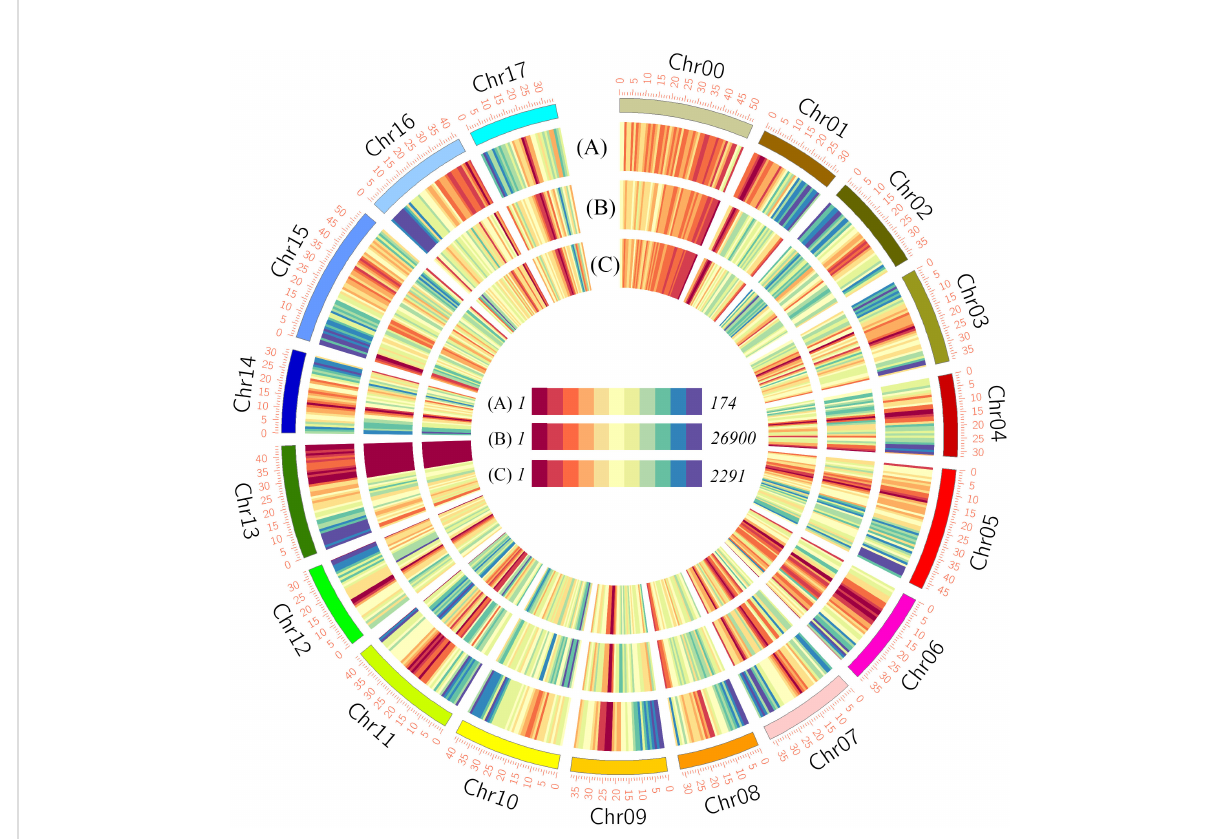
FIGURE 2 Circular overview of the variations between ‘ HanFu ’ and ‘ Huahong ’ . The outer circle (A) shows the numbers of genes within a 1-Mbp window; the intermediate circle (B) shows the number of SNVs between HanFu ’ and ‘ Huahong ’ within a 1-Mbp window; and the inner circle (C) shows the number of SVs between ‘ HanFu ’ and ‘ Huahong ’ within a 1-Mbp